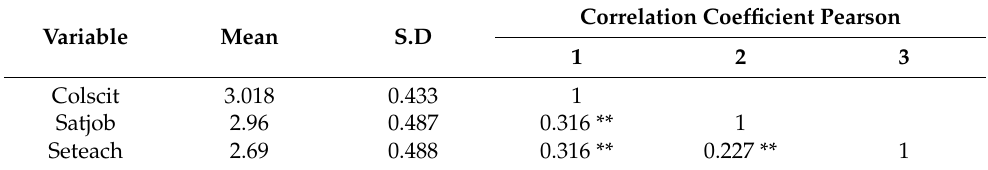
Table 3. Descriptive statistics of each latent variable ( n =